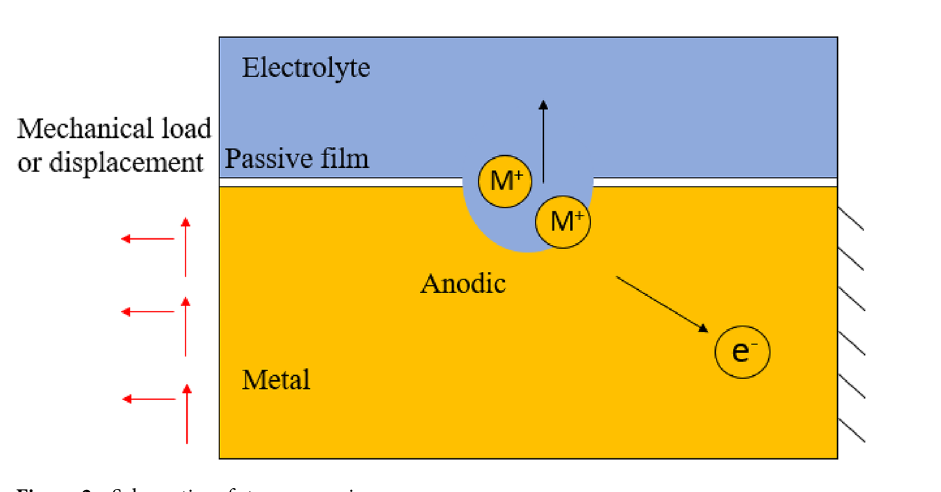
Figure 2. Schematics of stress